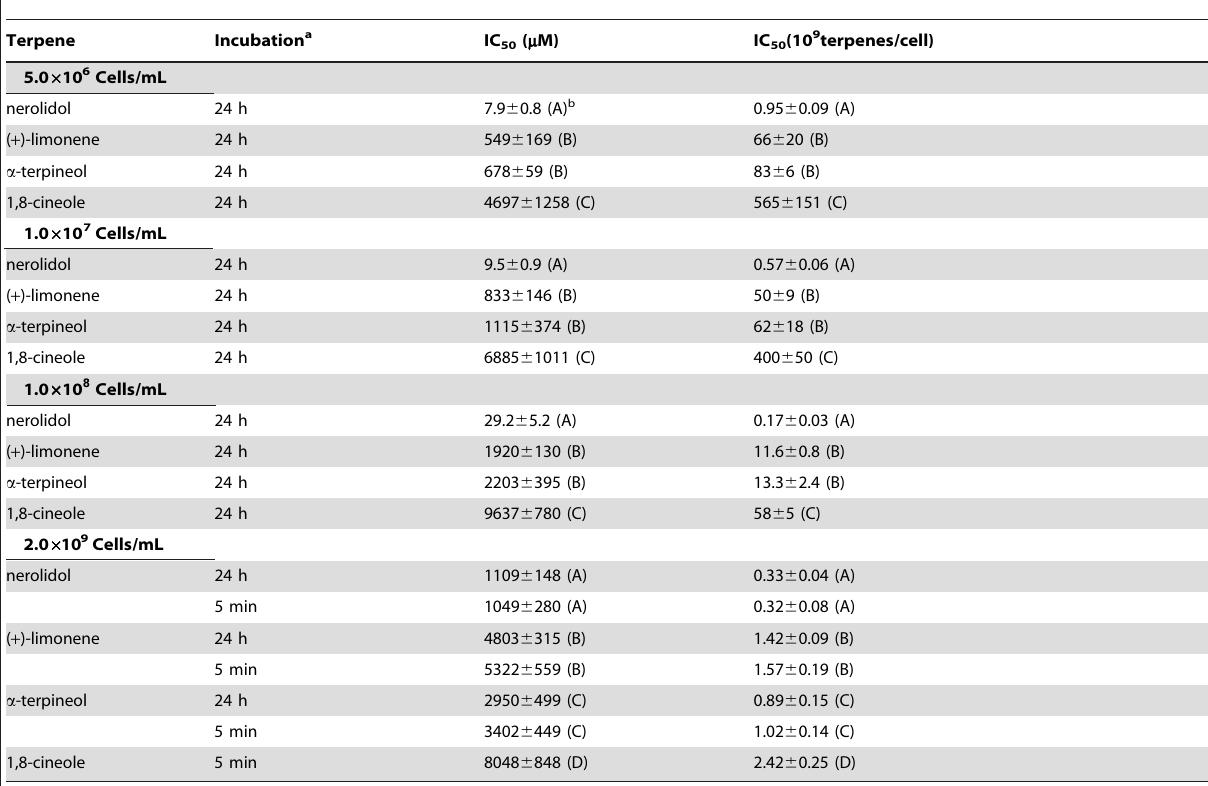
Table 1. Effect of terpenes against Leishmania amazonensis promastigotes (MTT assay).